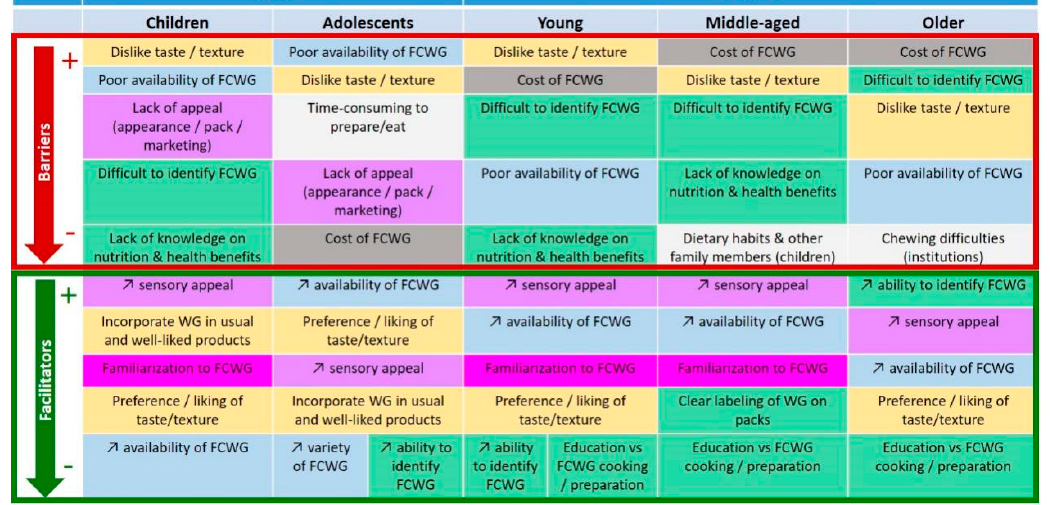
Figure 3. Main barriers to and facilitators of whole grain consumption in children and adults, as identified from the data collected in the frame of the current review. Factors are presented in decreasing order of their possible importance (from + to − ), for each age group separately, on the basis of the number of studies that have concluded that the corresponding factor was a barrier or a facilitator. WG, whole grain. FCWG, foods containing WG.